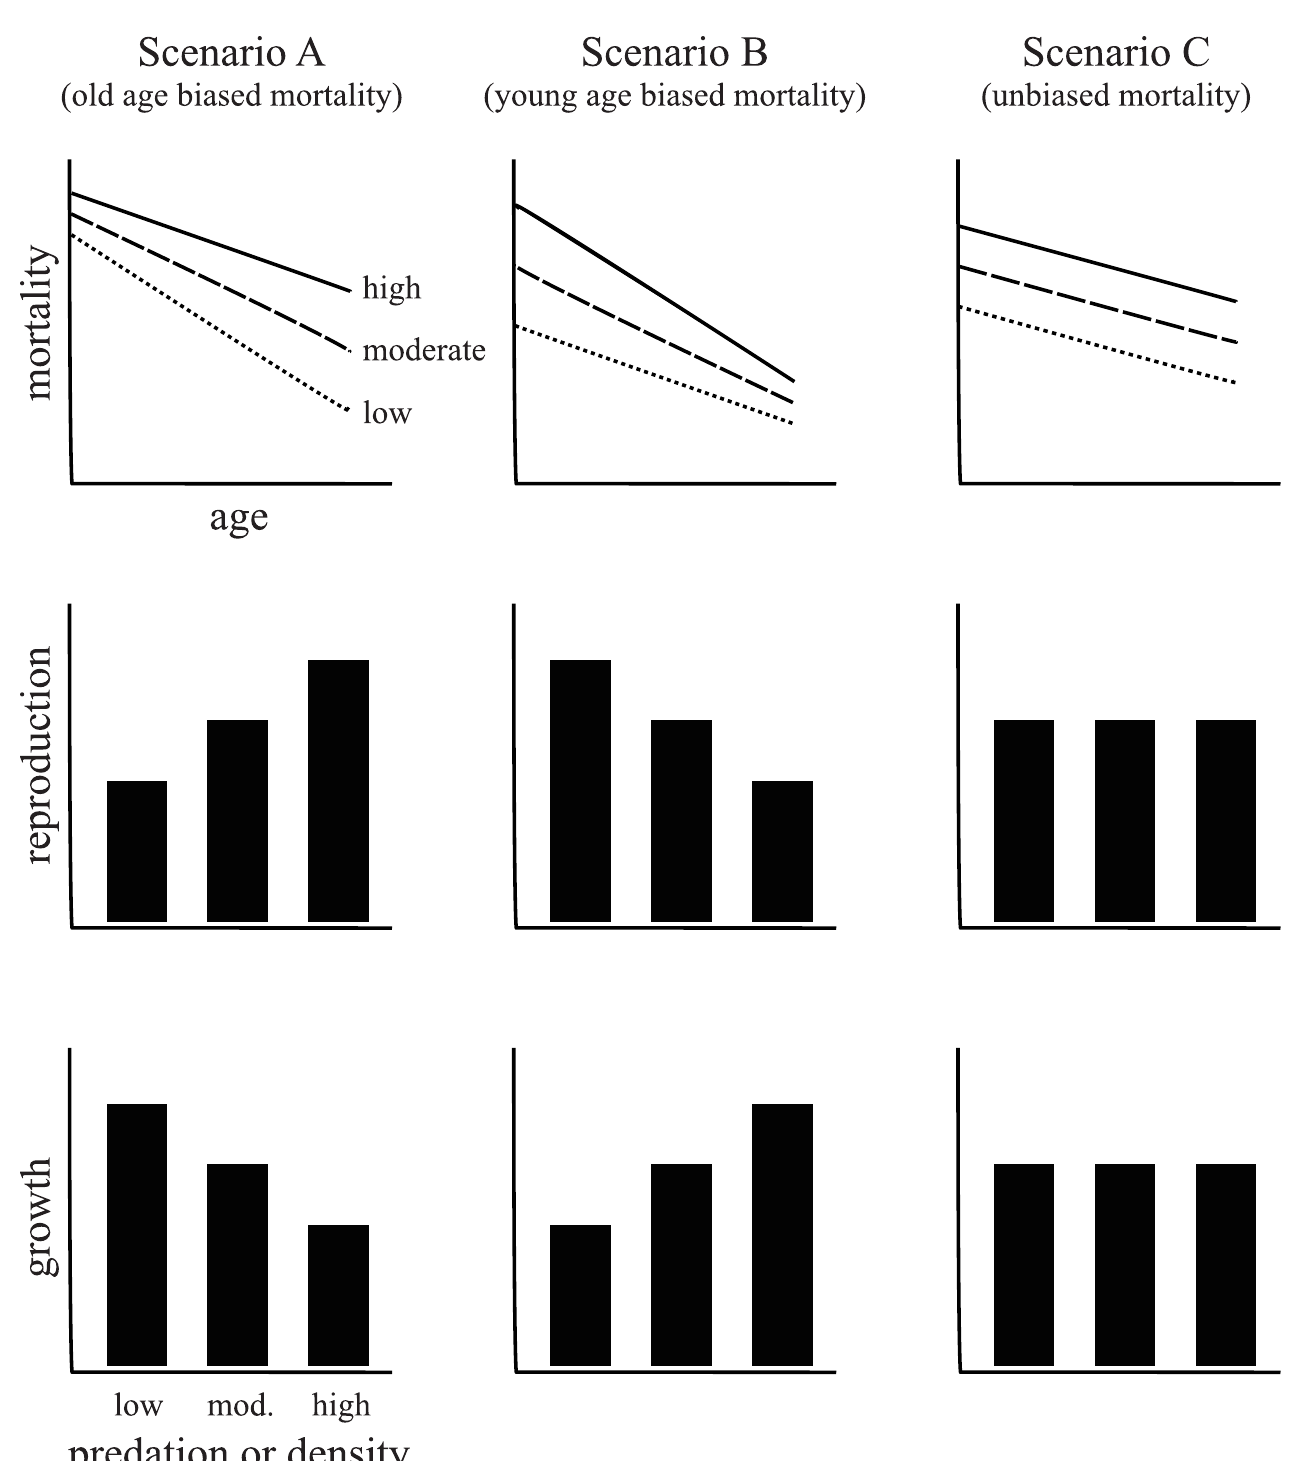
Fig 1. Predicted changes in female reproduction and growth as a function of potential changes in mortality that are biased towards older females (Scenario A), younger females (Scenario B), or equal across age classes (Scenario C).